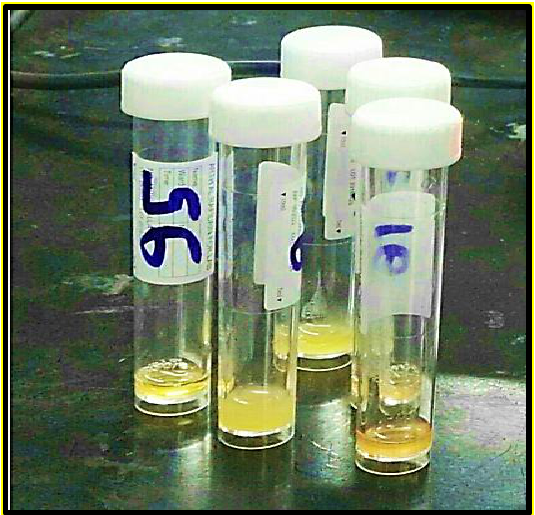
Fig.7: Photograph of the samples of blood serum.